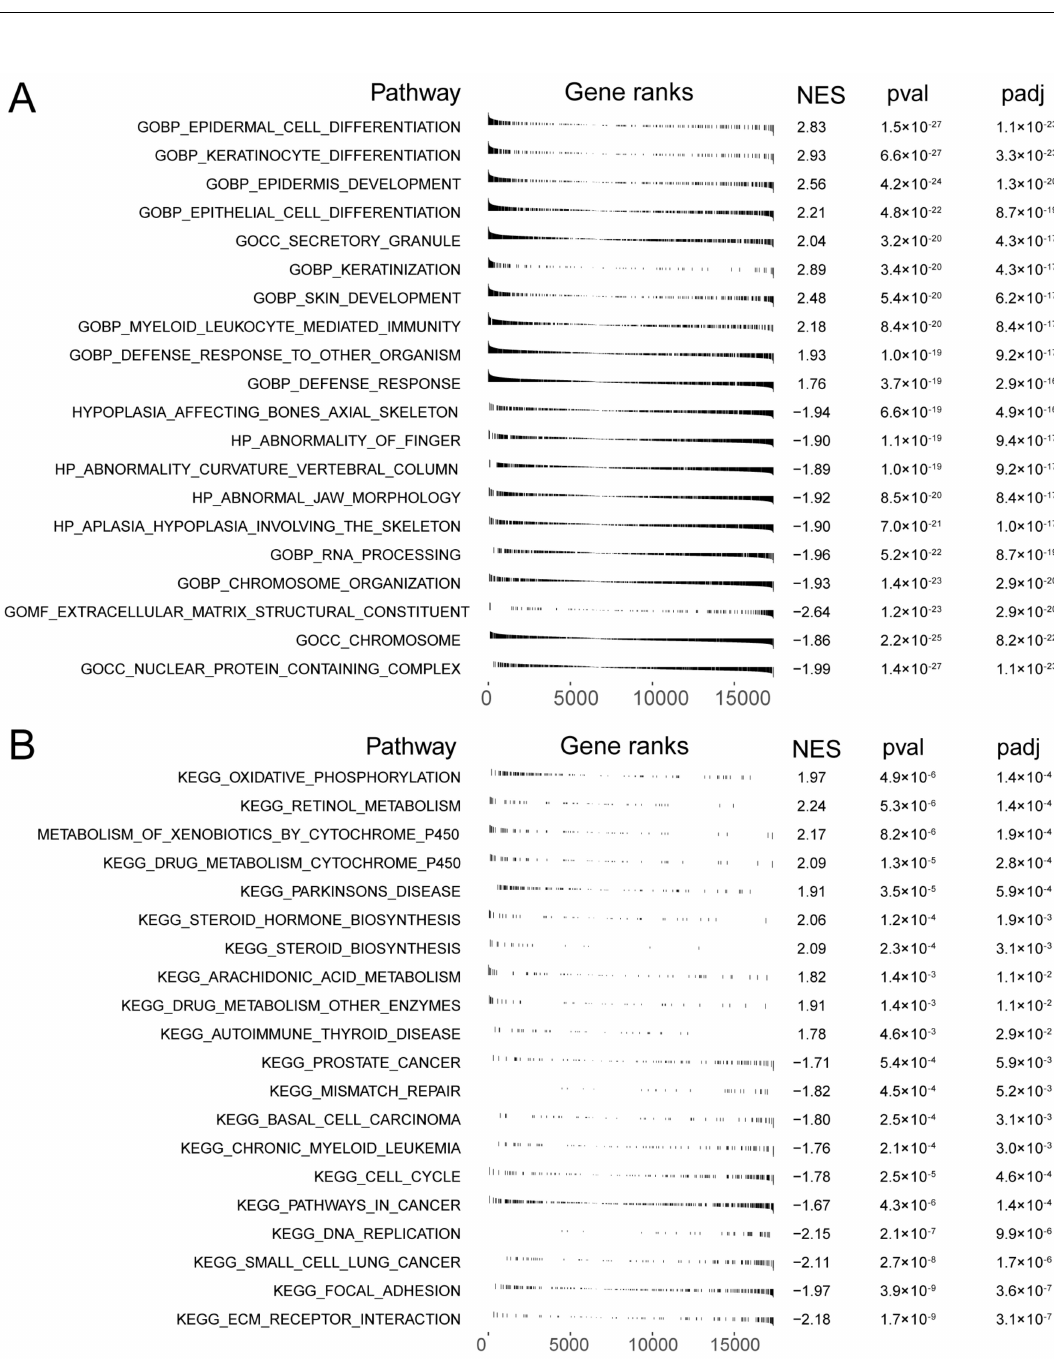
Figure 7. GSEA functional enrichment analysis in high- and low-risk groups. ( A ) Gene enrichment with GO terms of the selected genes. ( B ) KEGG enrichment analysis in high- and low-risk